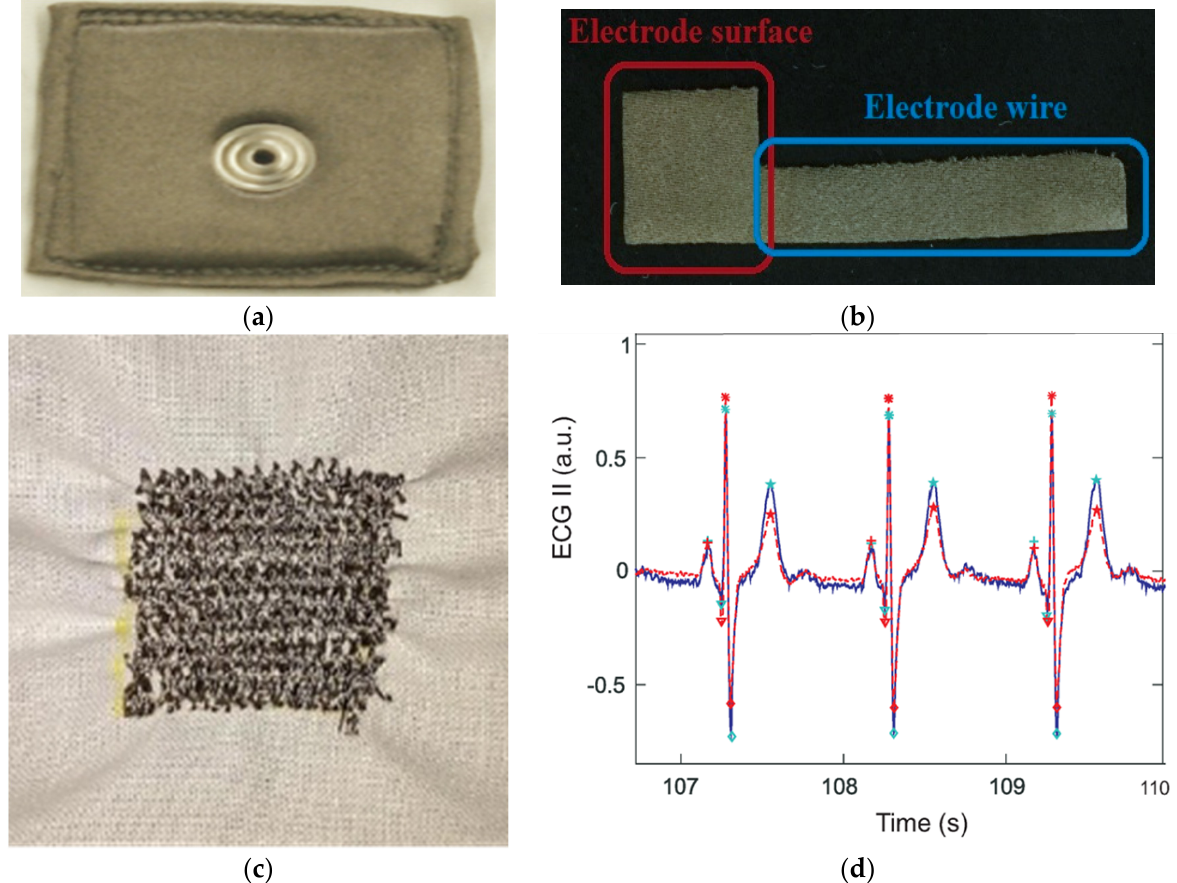
Figure 5. Examples of metal-coated textile-based ECG electrodes and resulting signal; ( a ) interior side of the silver-coated textile electrode, adopted from [74]; ( b ) structure of a textile electrode and connection track, adopted from [81]; ( c ) textile electrode developed by sewing silver thread onto fabric, adopted from [88]; and ( d ) comparison of ECG signals from a T-shirt with silver-plated active textile electrodes (blue) bandpass filtered (2–20 Hz) and reference Ag/AgCl electrode (red), adapted from [74].